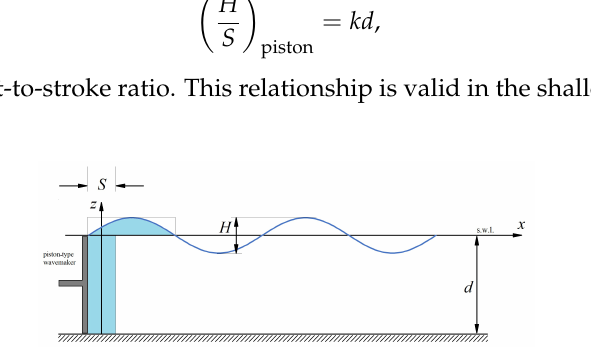
Figure 4. Sketch for the simplified shallow water piston-type wavemaker theory of